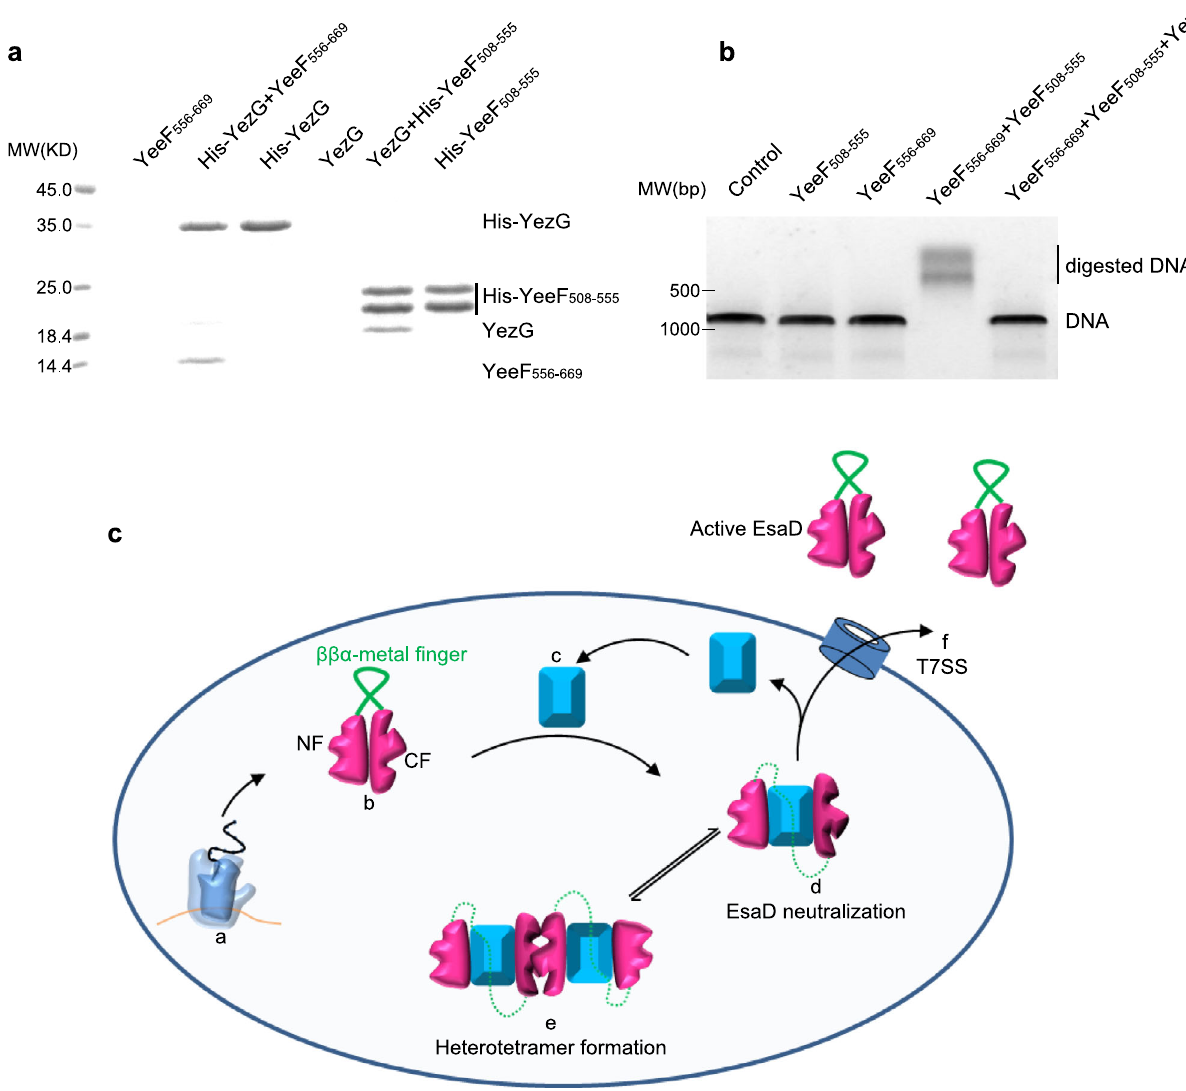
Fig. 5 | A conserved toxin inhibition mechanism in Gram-positive bacteria. a His-tag pull down assay. A His-SUMO tag was co-expressed on the N-terminus of YezG (His-YezG) and YeeF 508-555 (His-YeeF 508-555 ) to chelate with the nickel beads. Alltheproteinswerepuri fi edfrom E.Coli .ProteinsareindicatedbyCoomassieblue staining. The experiments were performed twice with similar results. b In vitro nucleaseactivityofYeeFfragments.Thegelwasstainedwithethidiumbromideand visualized under UV light. The experiments were performed three times with similarresults. c Cartoonrepresentationofthemolecularmodelforthemechanism